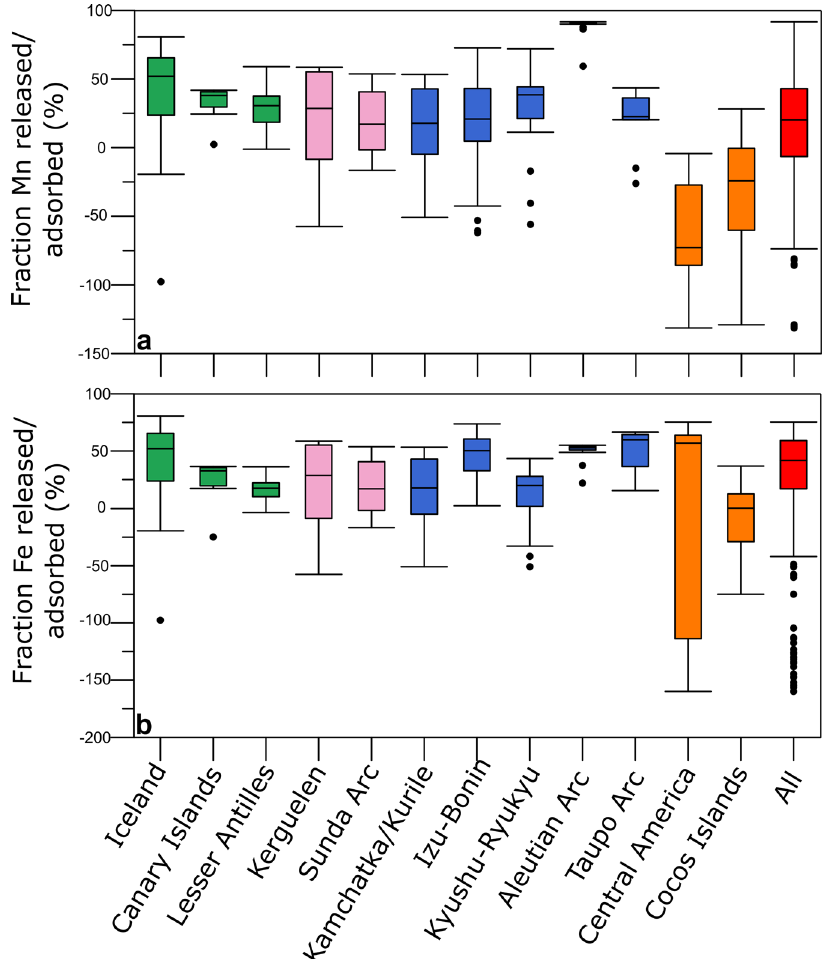
Fig. 2 Depletion factors for each volcanic province for both manganese and iron. Box plots detailing the distribution of depletion factor data from each volcanic province are presented for manganese ( a ) and iron ( b ), indicating likely levels of depletion/adsorption in each locality. Colour of the boxes indicates the ocean region of each province, either Atlantic (green), Indian (pink), North and West Paci fi c (blue) or East Paci fi c (orange). Boxes are de fi ned between the fi rst and third quartile (the interquartile range, IQR), with minimum and maximum whiskers representative of 1.5 times the IQR, and suspected outliers (>1.5 times the IQR) indicated by black